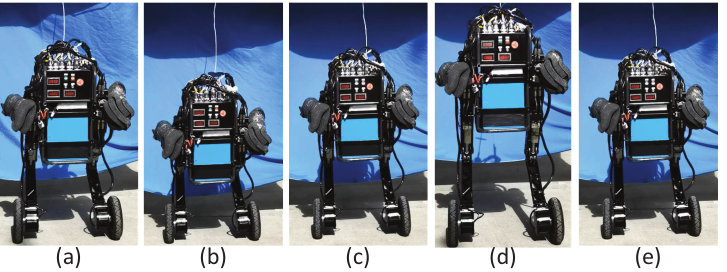
Figure 13. Snapshots of the physical test for changing height. The photos ( a , c , e ) correspond to the standing height of 0.6 m. Photos ( b , d ) correspond to the states with standing heights of 0.5 m and 0.7 m, respectively.